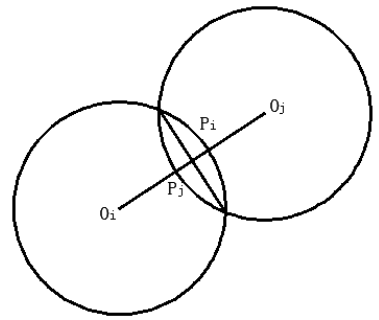
Figure 7. The interaction model between the steel ball i and the steel ball j.